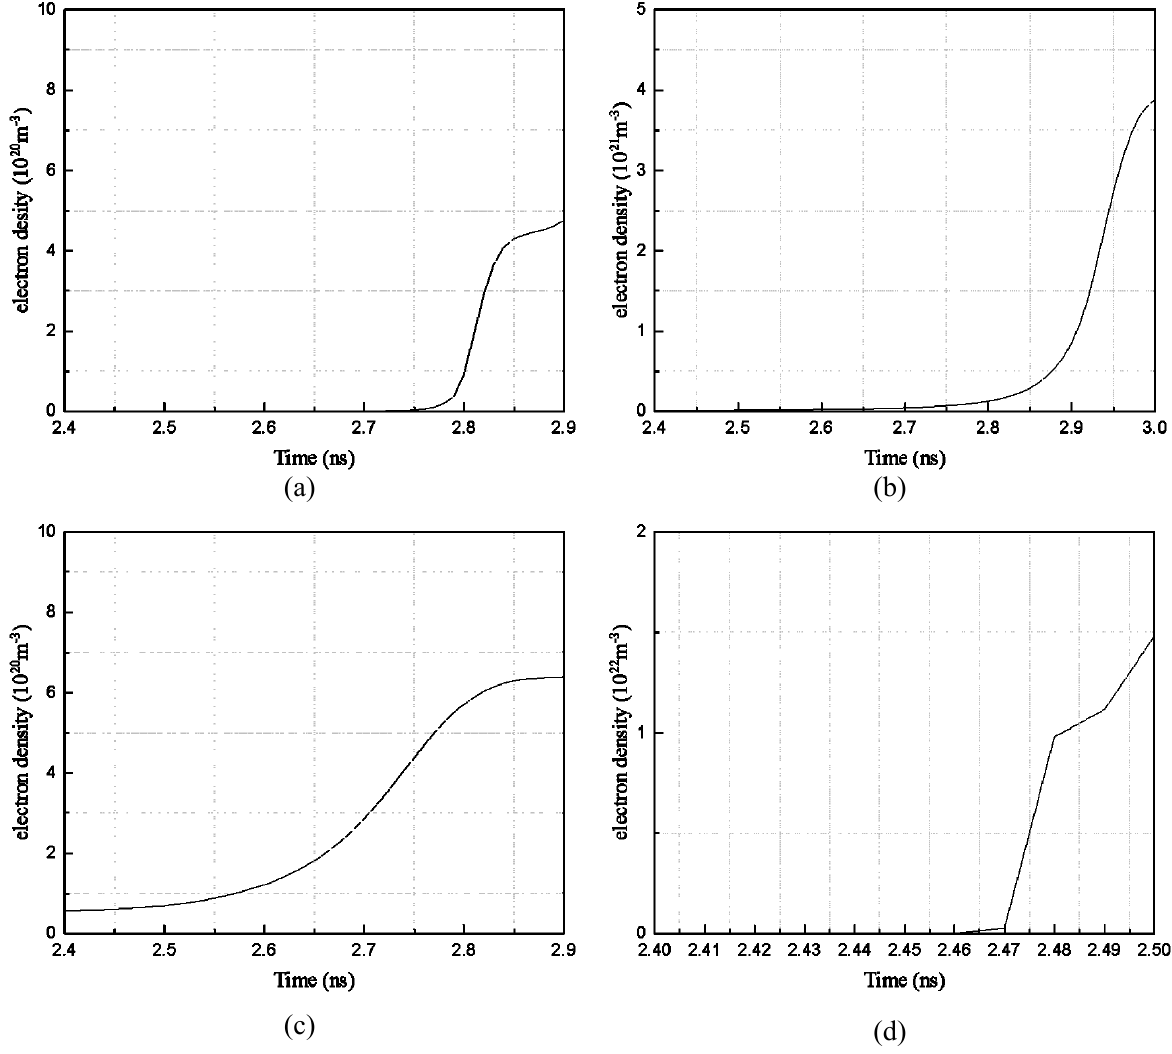
Figure 7. Variation of electron concentration at 4 points: ( a ) P1; ( b ) P2; ( c ) P3; ( d ) P4.